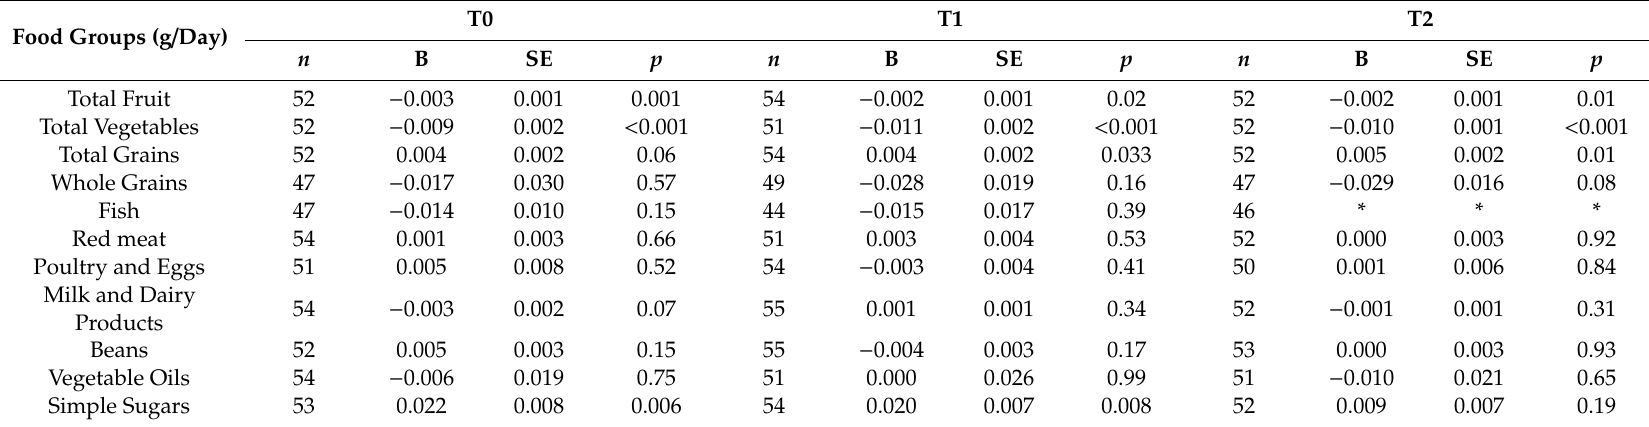
Table 3. Association between Dietary Inflammatory Index (DII ® ) and the consumption of food groups (g / day) of women with breast cancer in chemotherapy (CT) seen at Clinics Hospital at Federal University of Uberlandia, Minas Gerais, Brazil, 2014–2015. Food Groups (g /